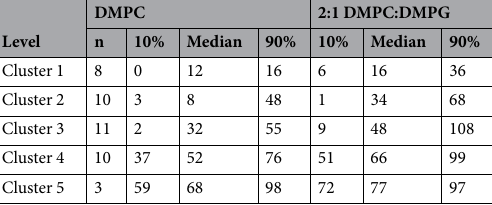
Table 3. Quantiles for peptide percent helicity in DMPC and 2:1 DMPC:DMPG LUVs as a function of peptide